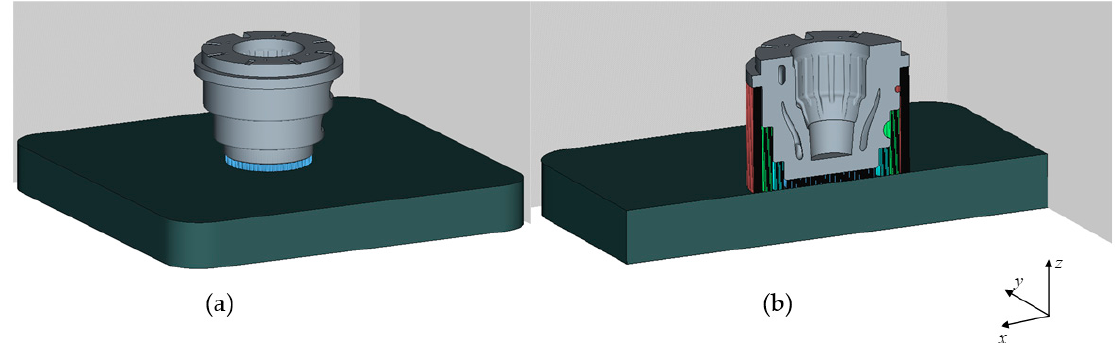
Figure 5. L-PBF machine setting for the fabrication of the mould insert: ( a ) positioning, orientation and supports on the base plate; ( b ) support structure definition in the region of the horizontal shoulders with progressively increased diameter.